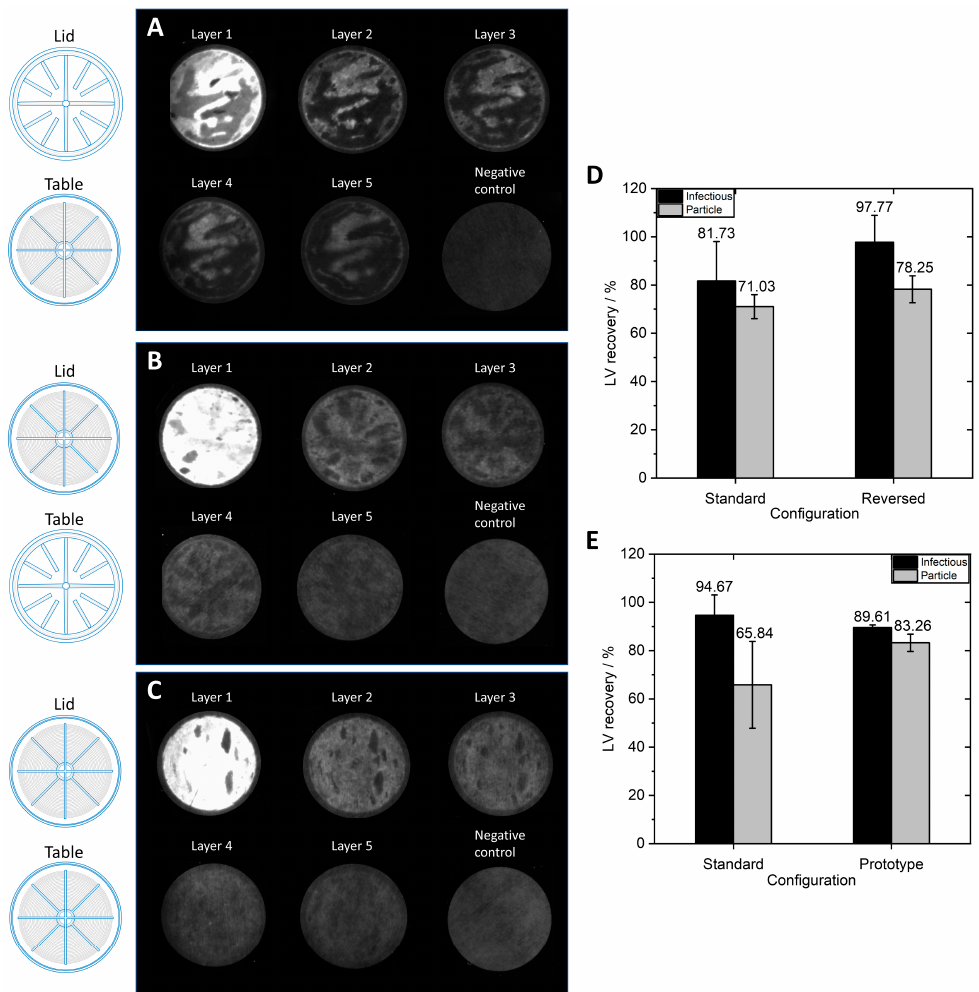
Figure 7. Influence of different MA100 configurations on the location of labeled LVs (anti-VSV-G Alexa Fluor ® 546 antibody) on the membrane after loading and on the recovery of infectious and particle LVs. Membrane layers were separated after the loading and washing steps of steric exclusion chromatography. The lid and table configurations of the housing are indicated on the left and include a ( A ) standard configuration, ( B ) reversed configuration, and ( C ) prototype configuration. ( D , E ) Infectious and particle LV recovery for the three configurations of the MA100 housing operated at 1.43 mL·min − 1 ·cm − 2 (N = 3 each). Data represent mean ± standard deviation.